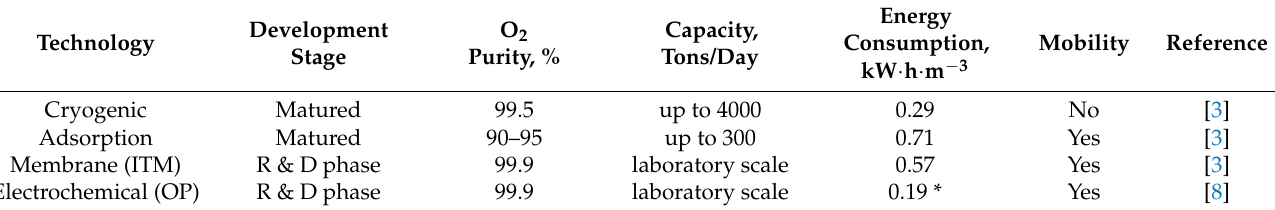
Table 1. Comparison of oxygen production